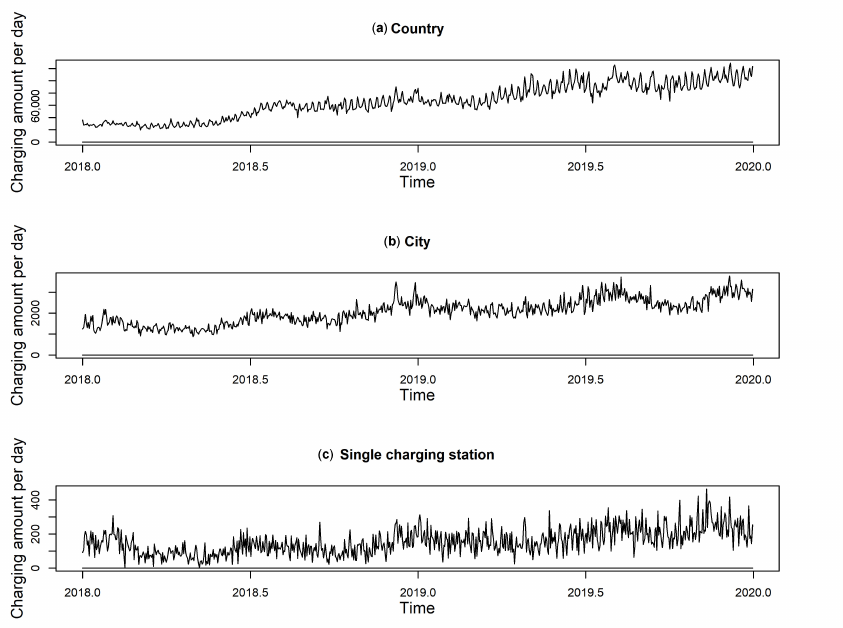
Figure 1. Time series plot of the electric vehicle (EV) charging amount at three geographical scales: ( a ) country, ( b ) city, and ( c ) single charging station. The y -axis presents the daily energy used that was calculated by aggregating the multiple charging events (unit: kW/day). The x -axis presents the periods from January 2018 to December 2019.